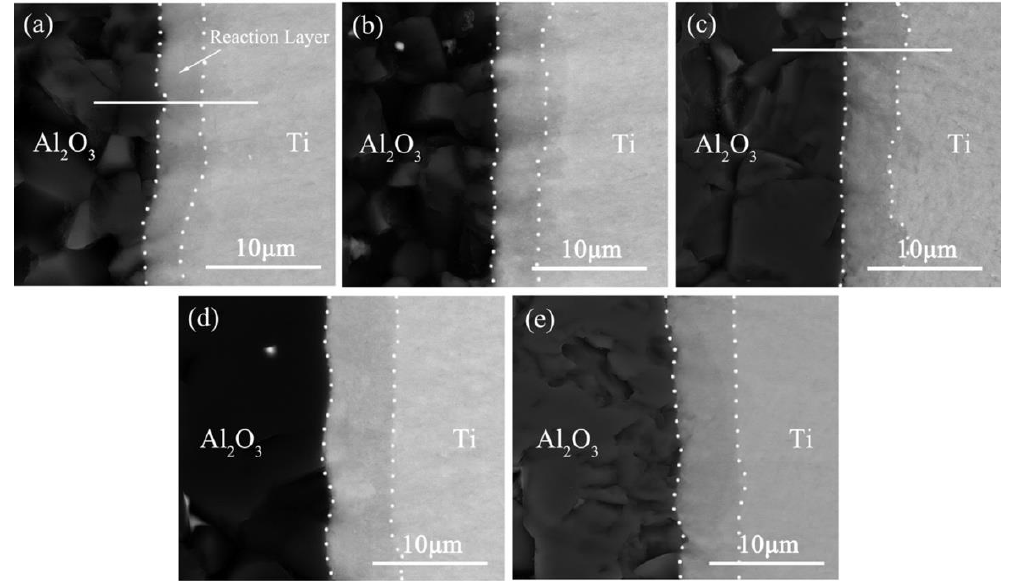
Figure 18. The microstructures of Ti/Al 2 O 3 joints diffusion bonded at 900 °C for 120 min under different voltages: ( a ) 0 V; ( b ) 300 V; ( c ) 700 V; ( d ) 1100 V; ( e ) 1500 V, reproduced from Reference [46] with permission of Elsevier, 2015.